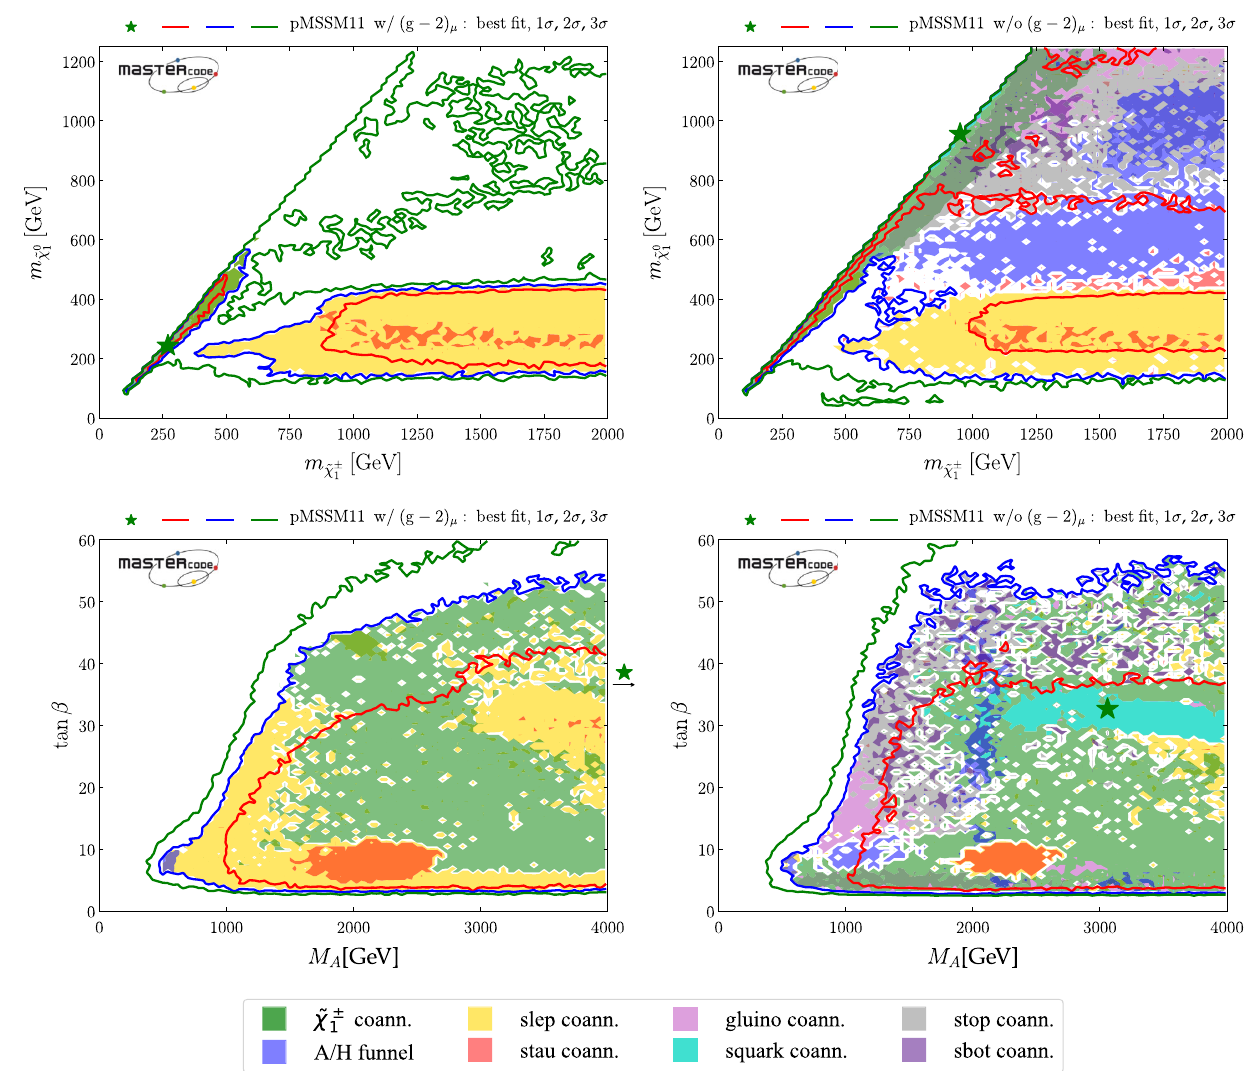
, m ) planes(upperpanels)andthe ( M ˜ χ 0 1 1